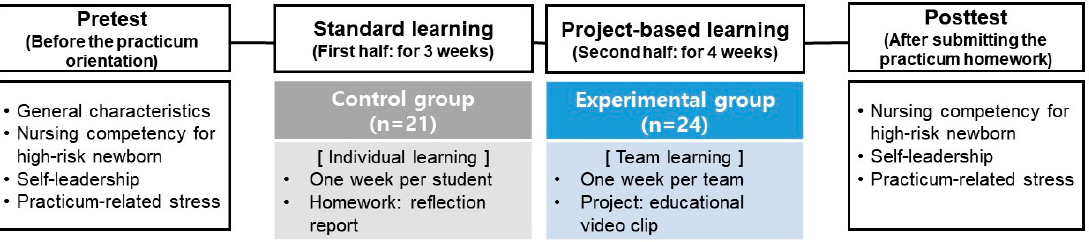
Figure 1. Research